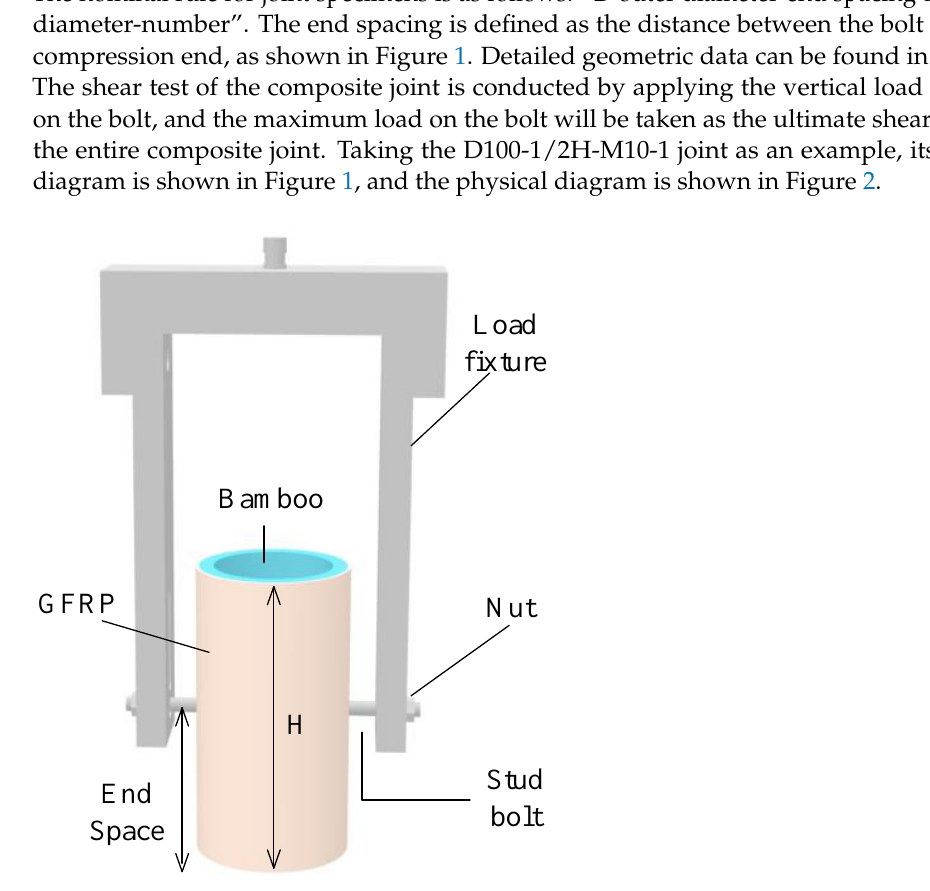
Table 1. Geometric data of different composite joint models.